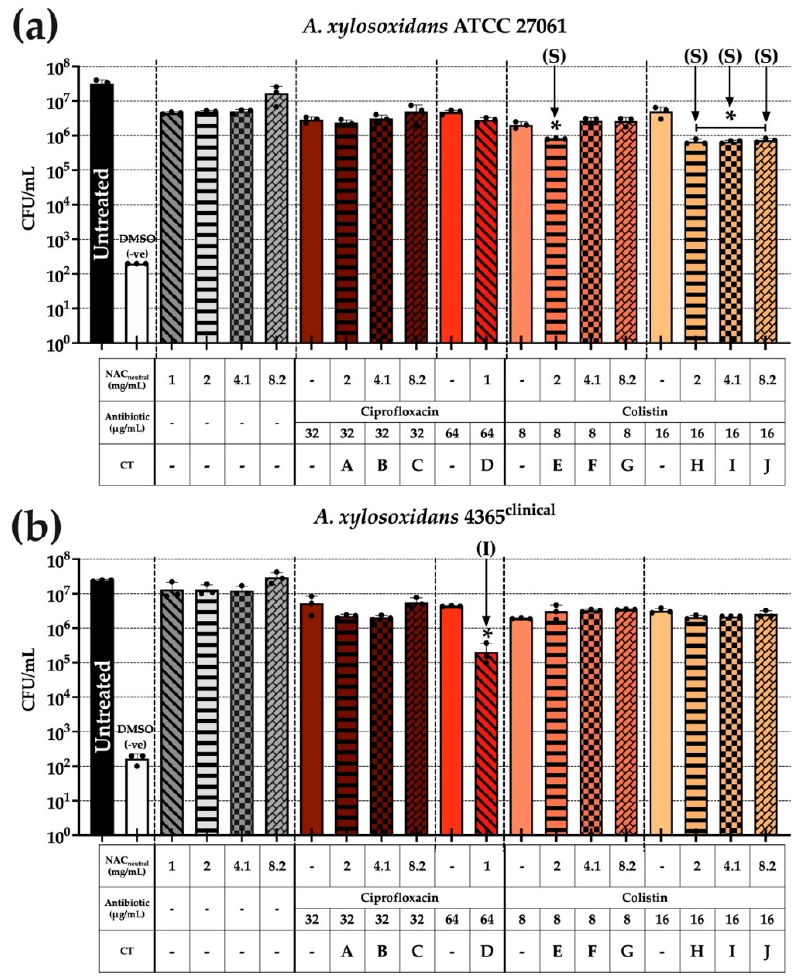
Figure 5. Combination treatment challenge against A. xylosoxidans invasion in BEAS-2B + 20% AS- MDM-1 cell model . Confluent BEAS-2B cells were washed and infected with OD 600 0.1 ± 0.02 for one hour to allow for intracellular invasion. Following this, cells were washed thrice with 100 μ g/mL gentamicin before addition of combinations in a final concentration of 20% ASMDM-1 and 80% DMEM medium for three hours. Cells were washed twice with 1 × PBS before being lysed and in- tracellular bacterial loads were enumerated using CFU/mL. ( a ) ATCC 27061 and ( b ) AX 4365. Cor- relation with planktonic synergy was determined previously and is denoted as ( S ) synergy and ( I ) indifferent. (*) indicates the results are statistically significant ( p ≤ 0.05) (*) based on unpaired Stu- dent’s t -tests (with Welch’s correction). Experiments were performed in biological triplicate (n = 3). 3.6. Synergistic Colistin Combination Therapy Reduced A. xylosoxidans Invasion in THP-1 Cells To determine intracellular invasion in THP-1 macrophages, differentiated cells were infected with A. xylosoxidans for one hour followed by a three-hour treatment exposure, where bacterial loads were significantly reduced, predominantly in colistin-based CT (Figure 6). ATCC 27061 successfully invaded the THP-1 cells and intracellular bacterial loads were reduced compared with both untreated control and individual components of the treatments D, H, and I (Figure 6a). Combination J was additive in planktonic states but did not display a significant intracellular bacteria reduction when compared to 16 μ g/mL colistin alone ( p > 0.05). Combinations H and I both displayed synergy in planktonic states which was translated into significant reductions of ~2 log 10 compared with the untreated